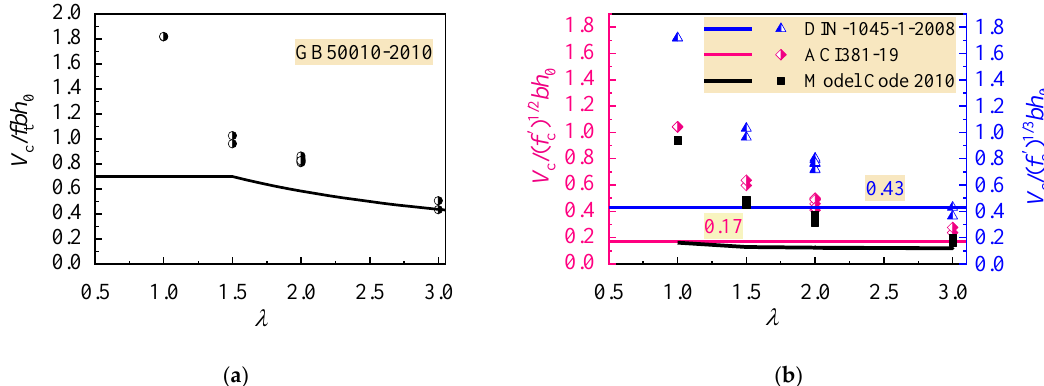
Figure 11. Comparison of shear strength attributed to the CRAC with current design codes: ( a ) China code GB50010; ( b ) ACI318-19 and DIN-1045-1-2008.